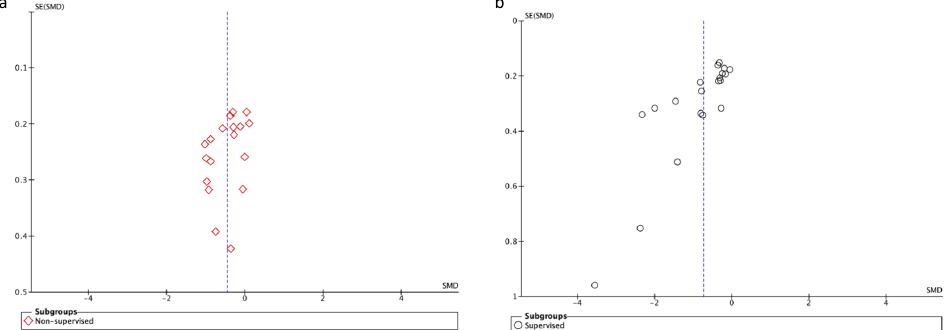
Figure 3. ( a ) Funnel plot of standard error (SE) against standardized mean difference (SMD) for the assessment of publication bias in the investigation of the CRF outcome in non-supervised training programs. ( b ) Funnel plot of standard error (SE) against standardized mean difference (SMD) for the assessment of publication bias in the investigation of the CRF outcome in supervised training programs.